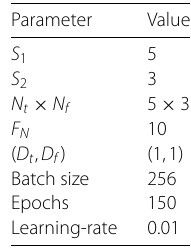
Table 1 Settings of